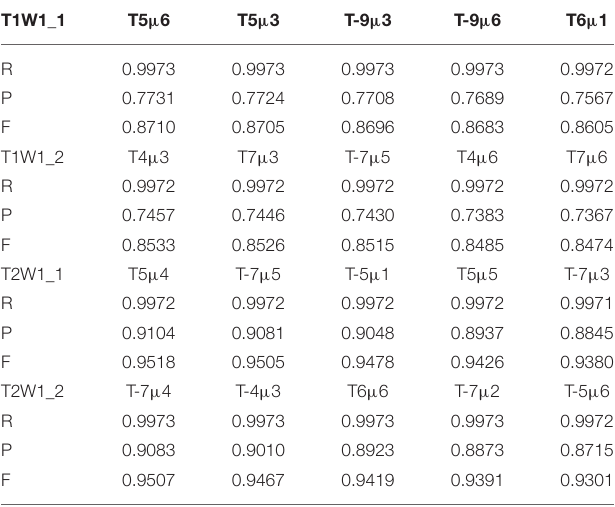
TABLE 1 | Values of T and µ for group